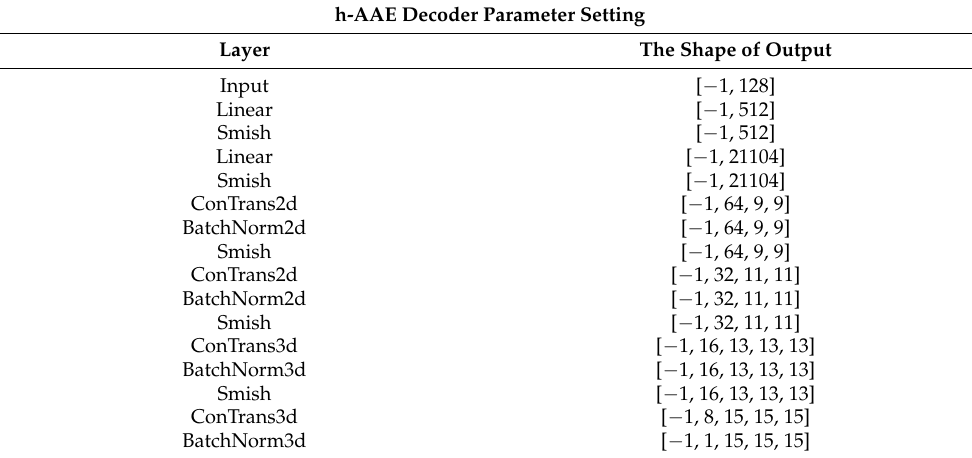
Table 3. The shape of layers in the h-AAE model for decoding.